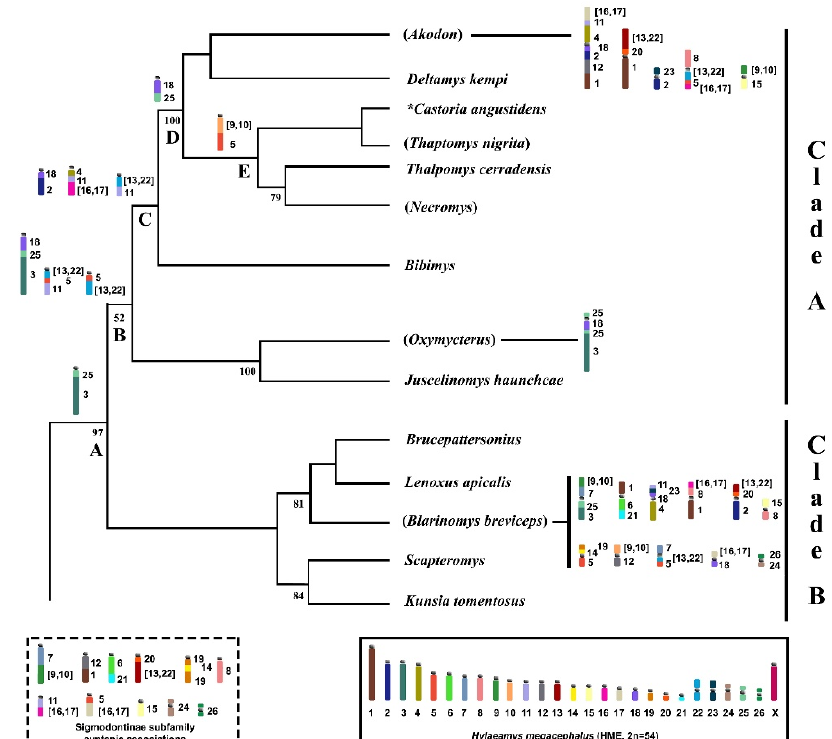
Figure 4 . Part of the phylogeny from D’Elía [27] of the Akodontini tribe obtained by a Maximum Parsimony analysis (Cytb and/or IRBP) with modifications exhibiting sister clades A and B. Numbers below branches indicate parsimony jackknife values. Only values above 50% are shown. The box encloses an idiogram of the HME karyotype elaborated by Oliveira da Silva et al. [9], as assessed based on HME probes [23]. Idiograms above nodes indicate syntenic associations shared among lineages, which are based on taxa analyzed by chromosome painting with HME probes and G-banding patterns: Node A (Akodontini tribe), node B (clade A), node C ( Akodon , Deltamys , Castoria , Thaptomys , Thalpomys , Necromys , and Bibimys ), node D ( Akodon , Deltamys , Castoria , Thaptomys , Thalpomys , and Necromys ), node E ( Castoria , Thaptomys , Thalpomys , and Necromys ). Idiograms within dashed line correspond to syntenic associations for the Sigmodontinae subfamily. Idiograms beside taxa names indicate autapomorphic characters. Taxa analyzed by chromosome painting with HME probes are shown within parentheses. *Referred to as “ Akodon ” serrensis by D’El í a